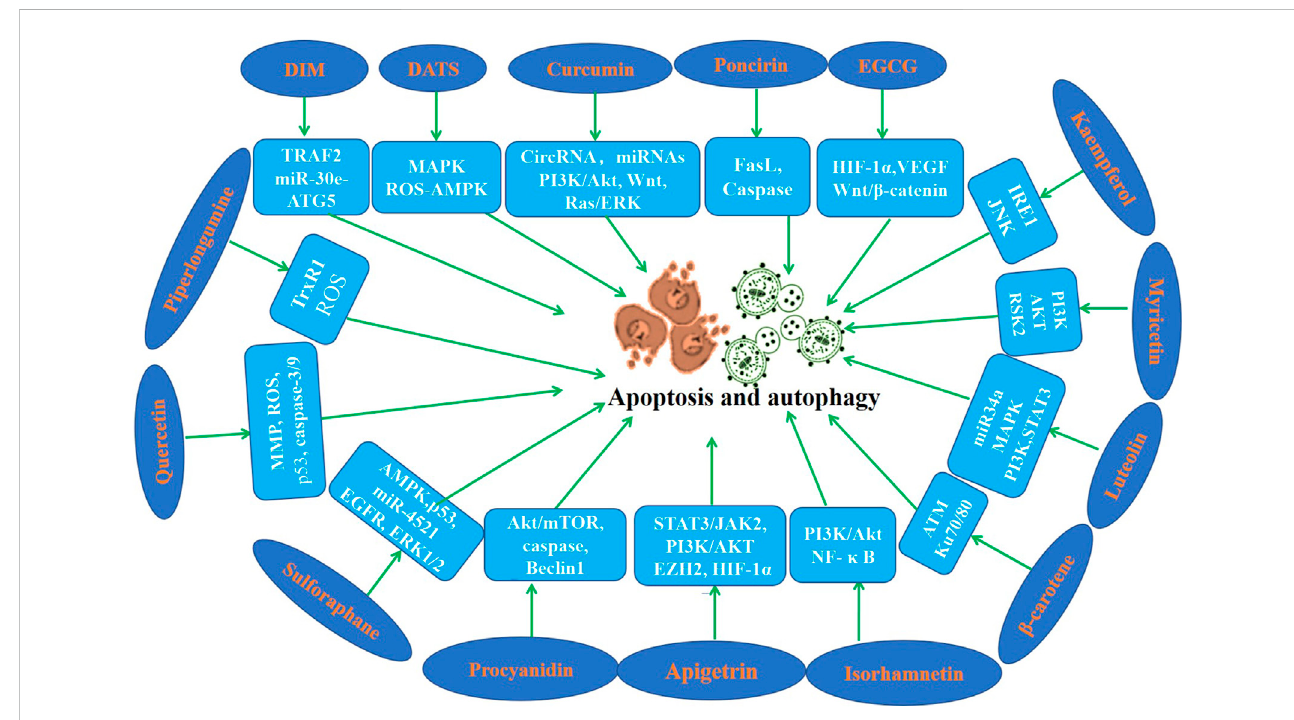
FIGURE 3 Molecular mechanism of anti-GC effect of representative phytochemicals by regulating apoptosis and autophagy.